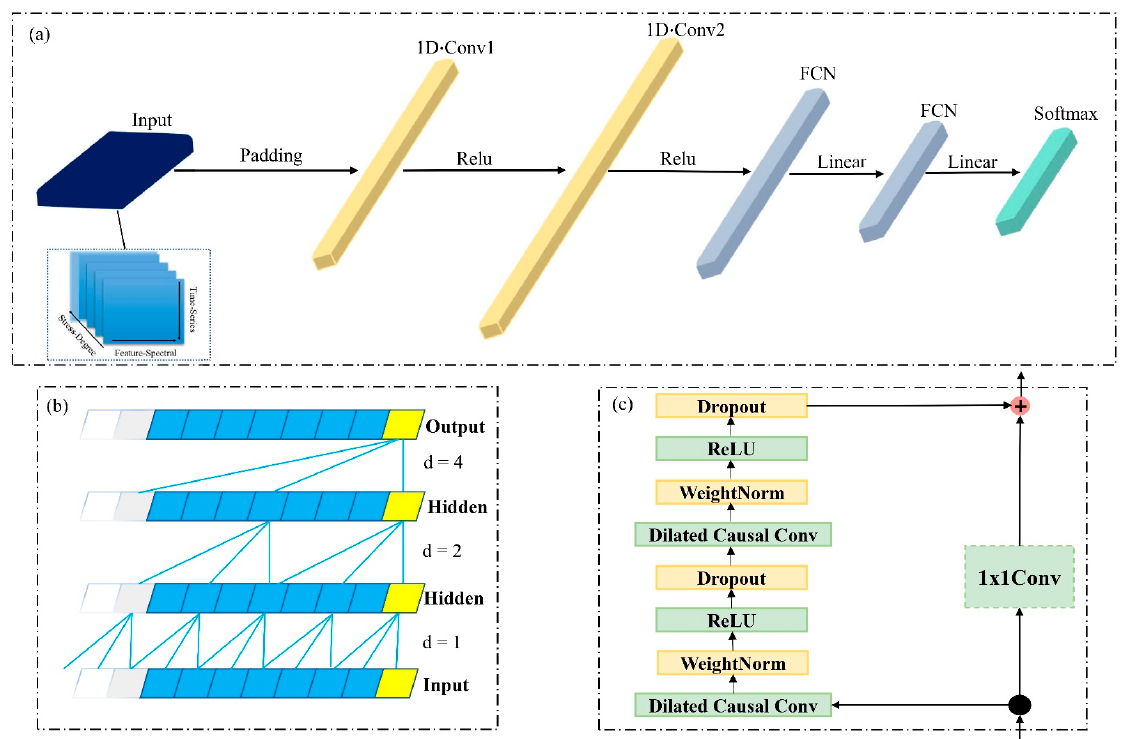
Figure 2. ( a ) SF-TCN network structure; ( b ) dilated convolution method; ( c ) residual